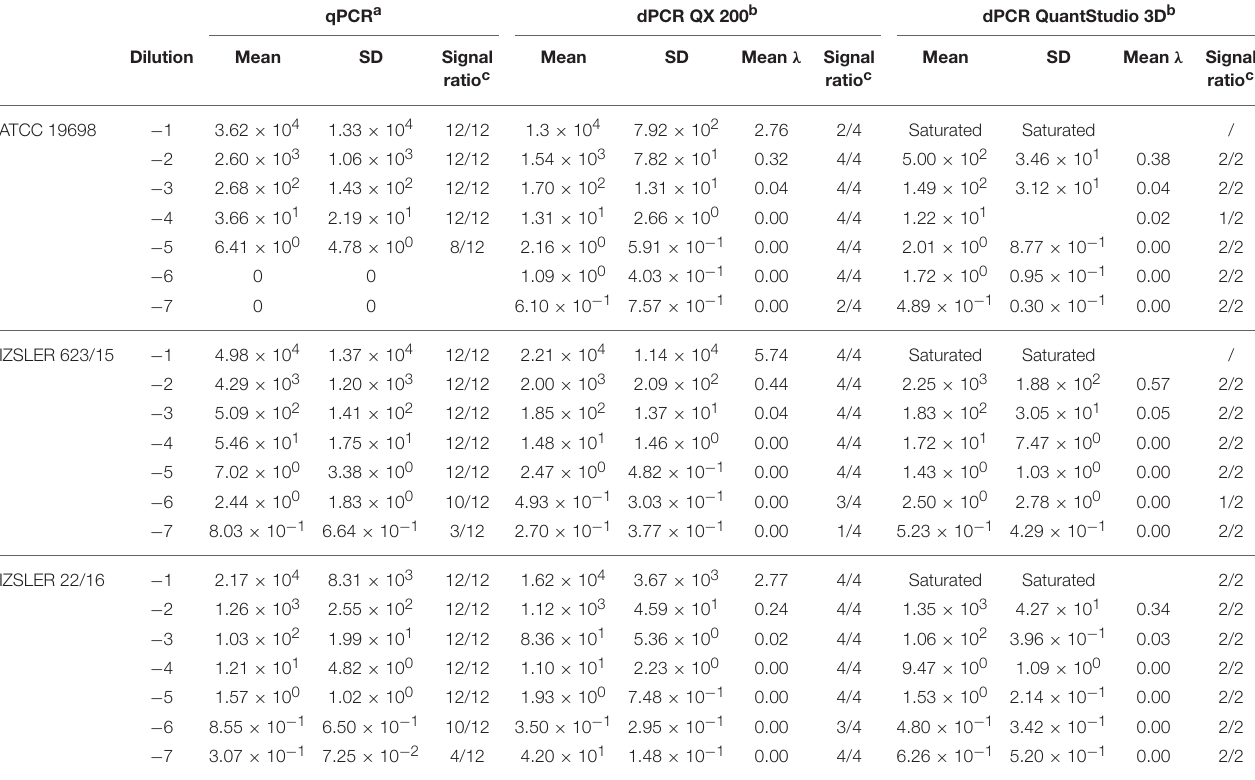
TABLE 2 | Experimental output of MAP cells obtained by f57-qPCR, f57- QX 200 dPCR and f57- QuantStudio 3D